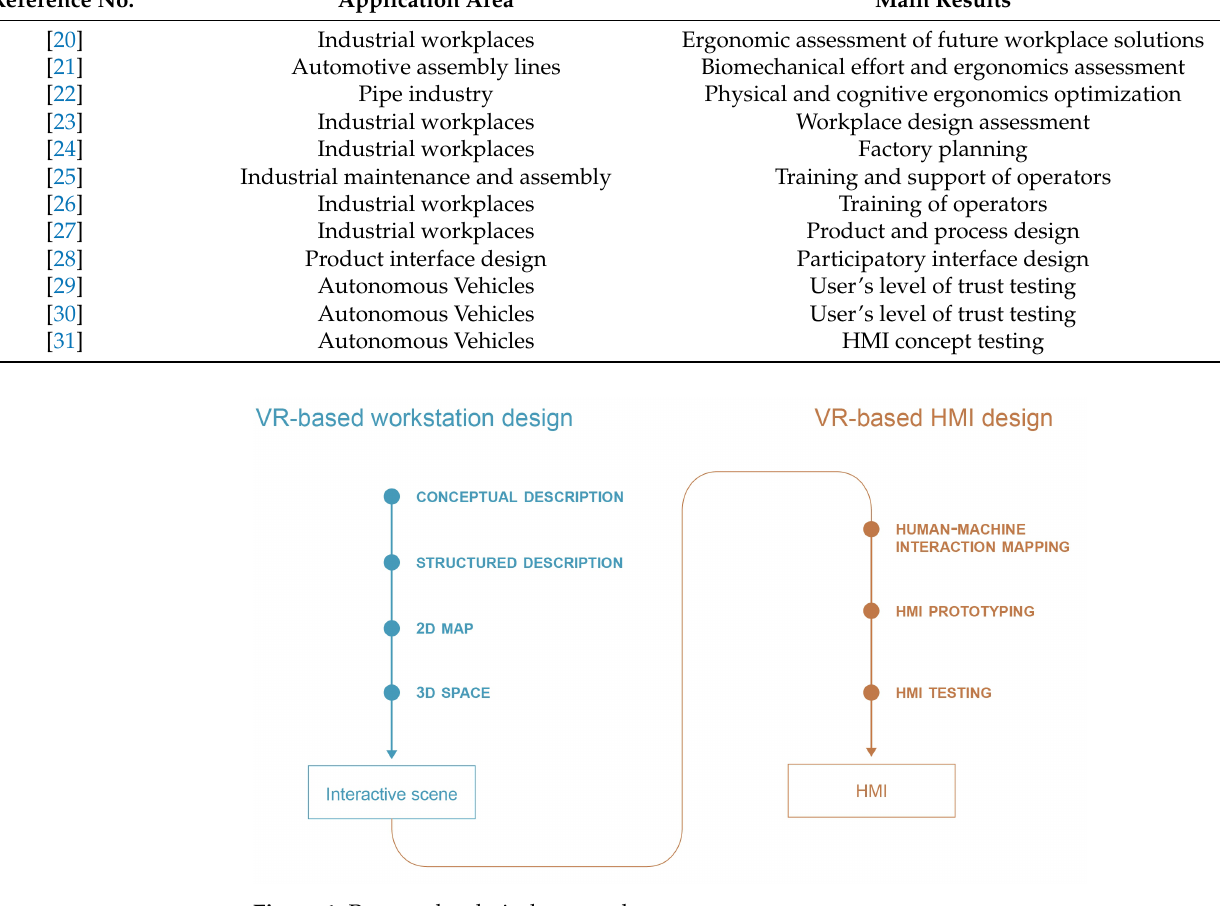
Figure 1: rapid prototyping of the workstation layout and HMI design. The first one